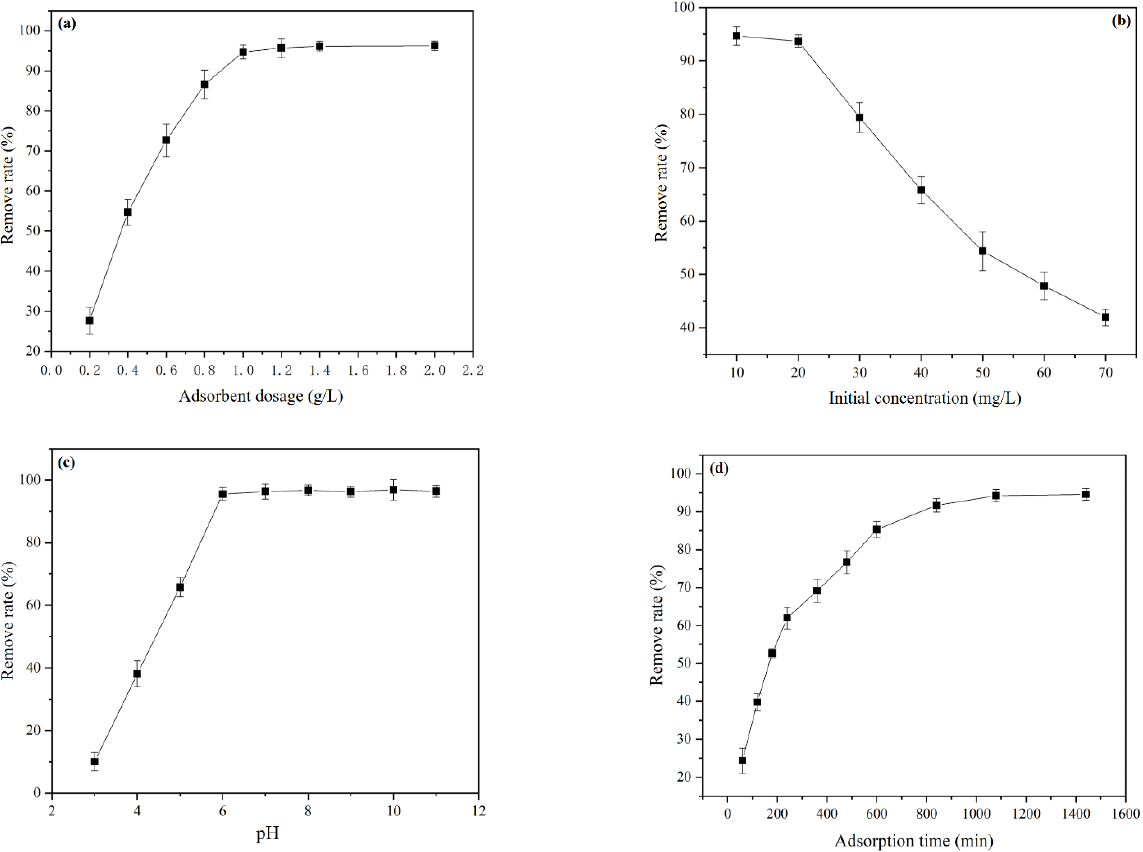
Figure 4. Single factor adsorption results: ( a ) adsorbent dosage and remove rate, ( b ) initial concentration and remove rate, ( c ) pH and remove rate, and ( d ) time and remove rate.